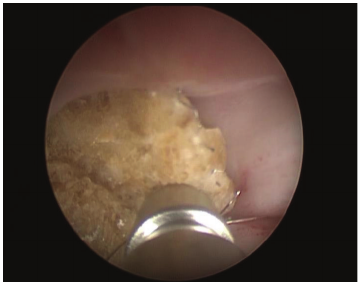
Figure 6: Image from the percutaneous nephrolithotomy shows grasper removing parts of the encrusted mesh stent.